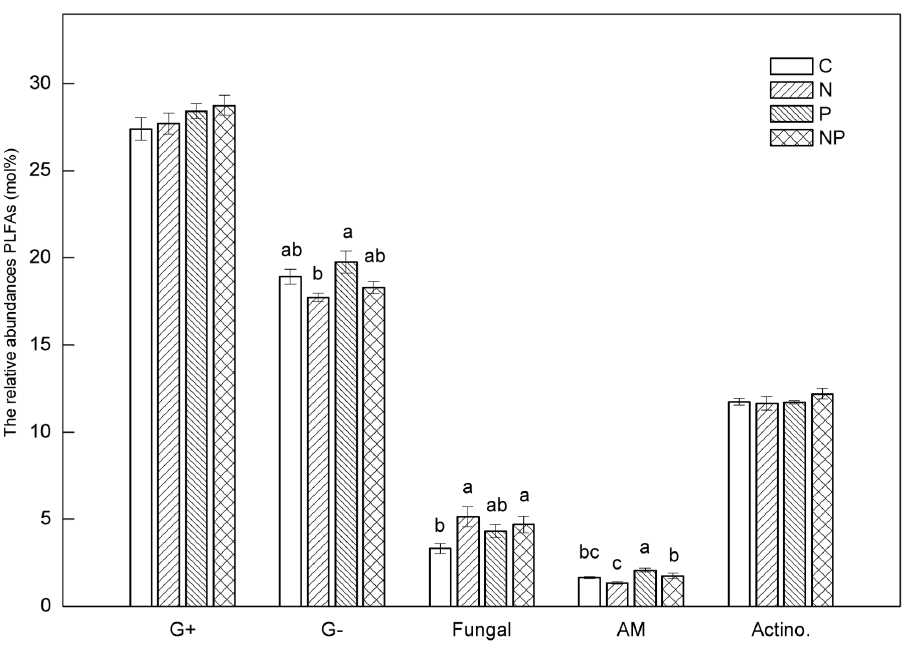
Figure 5. The relative abundances of the individual PLFAs (mol %) in soil samples. G + : the proportion of gram-positive bacterial PLFAs; G 2 : the proportion of gram-negative bacterial PLFAs; Fungi: the proportion of fungal PLFAs; AM: the proportion of AM fungal PLFAs; Actino.: the proportion of actinomycetes PLFAs. Significant differences (p , 0.05) among treatments are indicated by different letters. Error bars show SE (n=5).